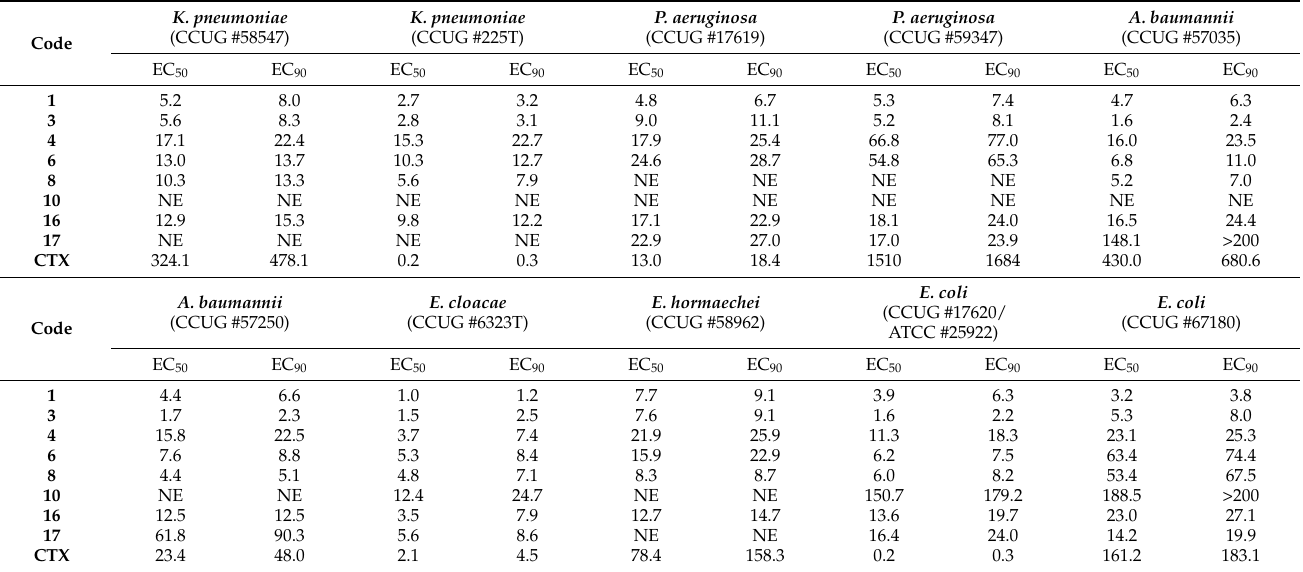
Table 2. Effective concentrations of 1 , 3 , 4 , 6 , 8 , 10 , 16 , 17 and CTX against the Gram-negative set of ESKAPE and E. coli isolates with different antibiotic susceptibility profiles.